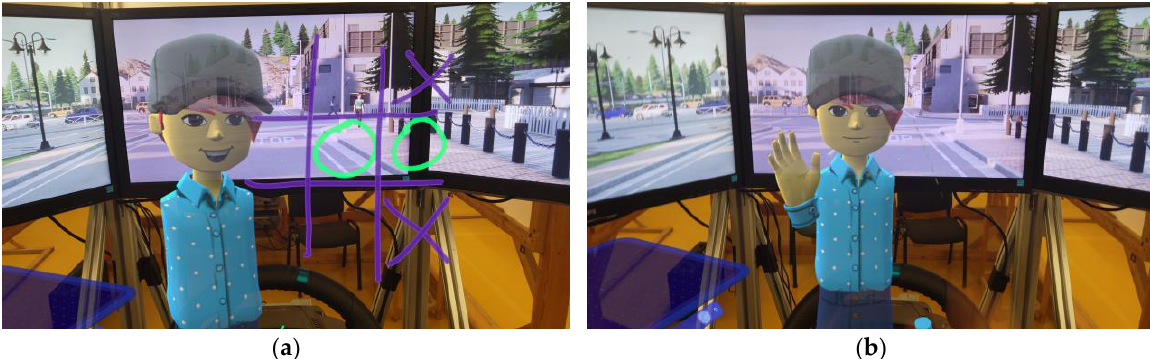
Figure 3. Screenshots from HoloLens 2: ( a ) collaborative tic-tac-toe game using Microsoft Mesh application; ( b ) the 3D avatar waving at the participant.